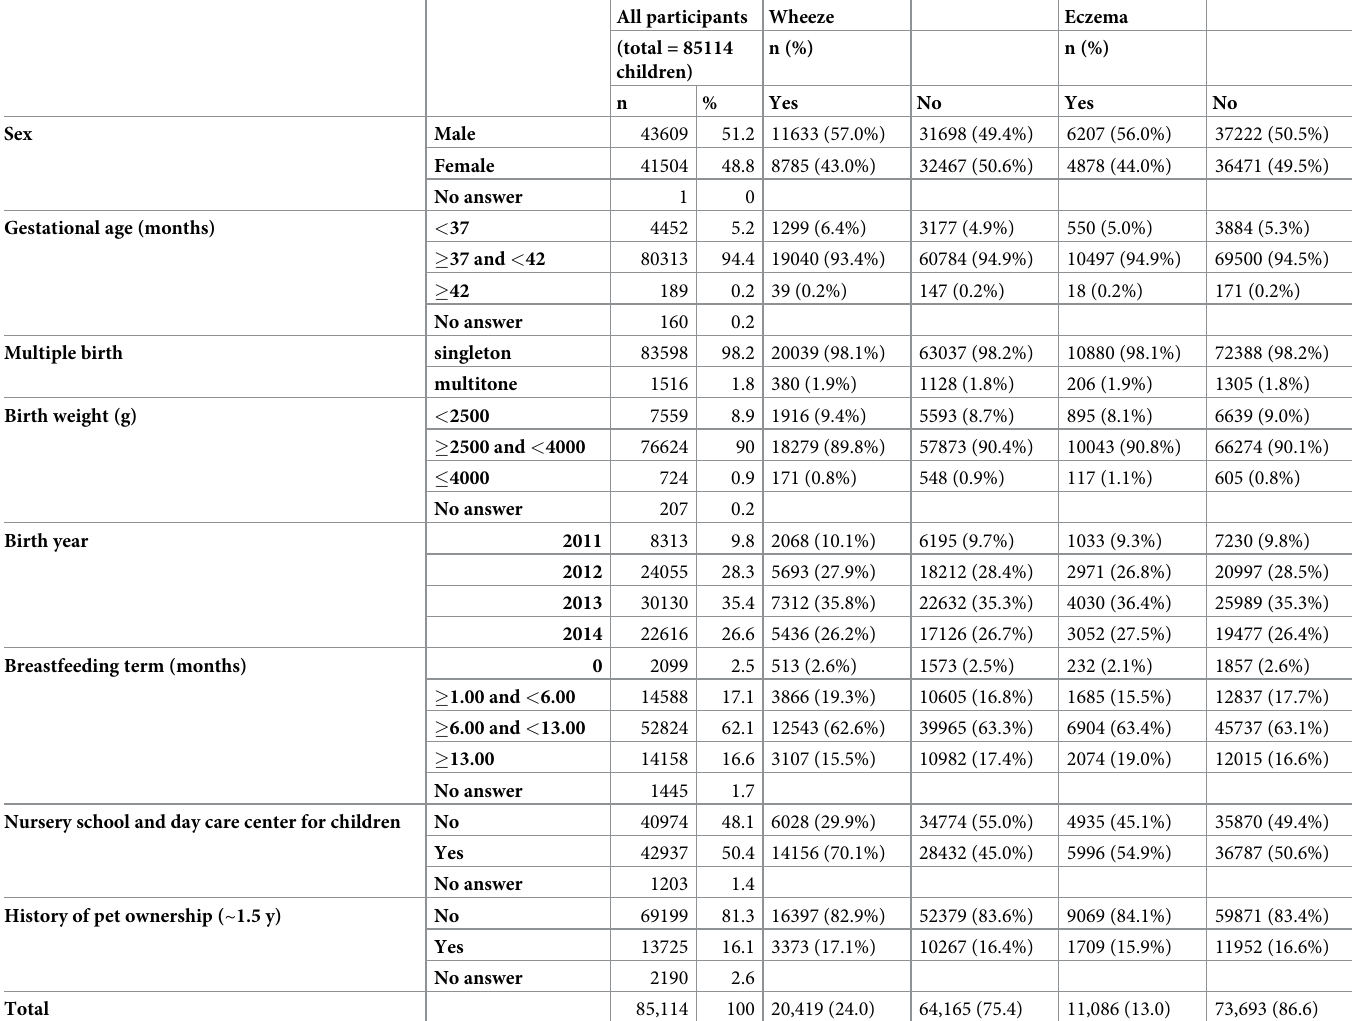
Table 2. Characteristics of the participants